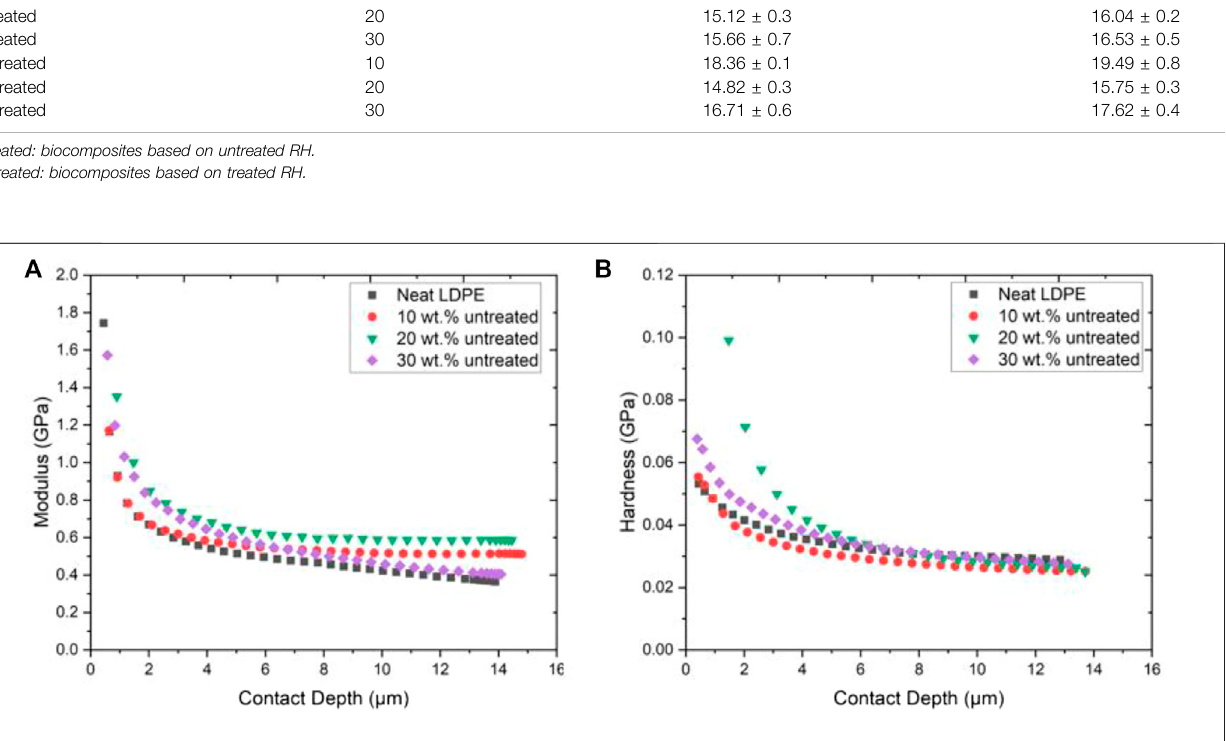
FIGURE 6 | Modulus and hardness as a function of contact depth: (A) modulus curves of untreated RH reinforced biocomposites with loadings of 10, 20, and 30 wt%; (B) hardness curves of untreated RH reinforced biocomposites with loadings of 10, 20, and 30 wt%.